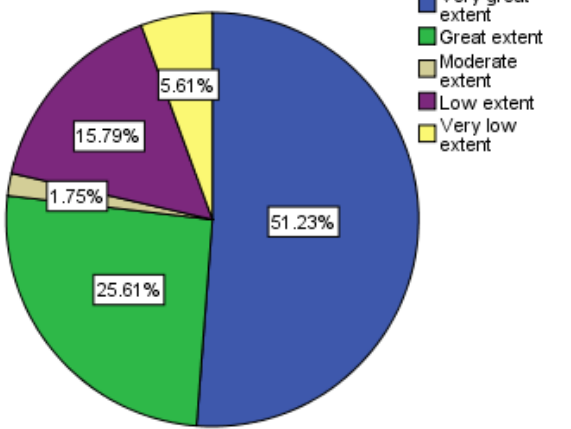
Figure 4. Pie chart showing the responses on ingratiation